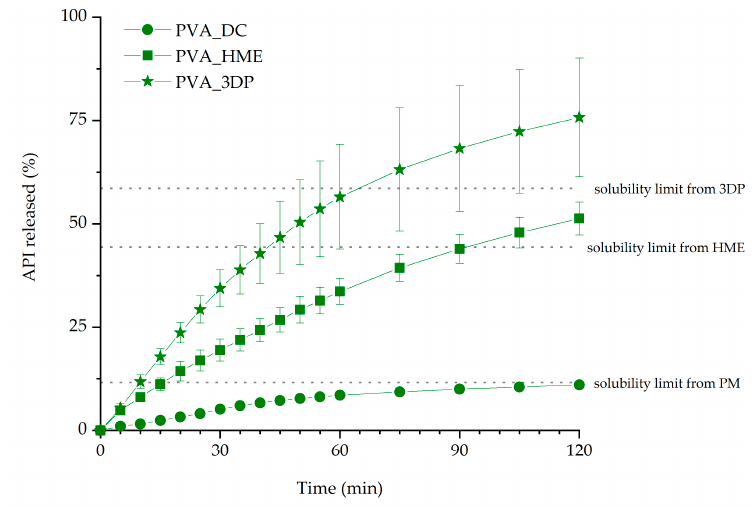
Figure 8. The influence of the technological process on the release profiles of itraconazole from PVA-based tablets (infill density equal to 35%).